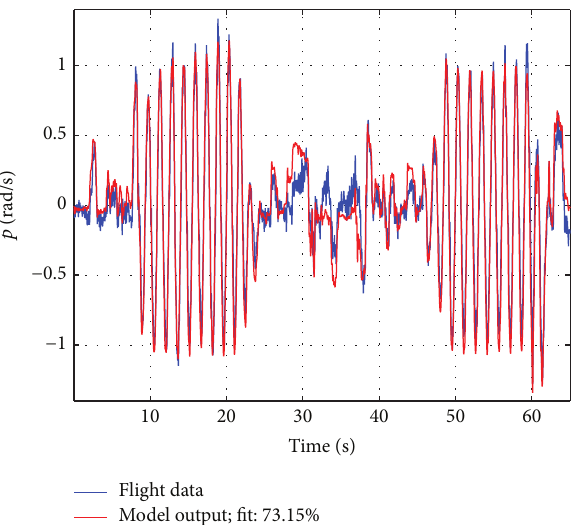
Figure 3: The roll rate response of the flight data and the model output.